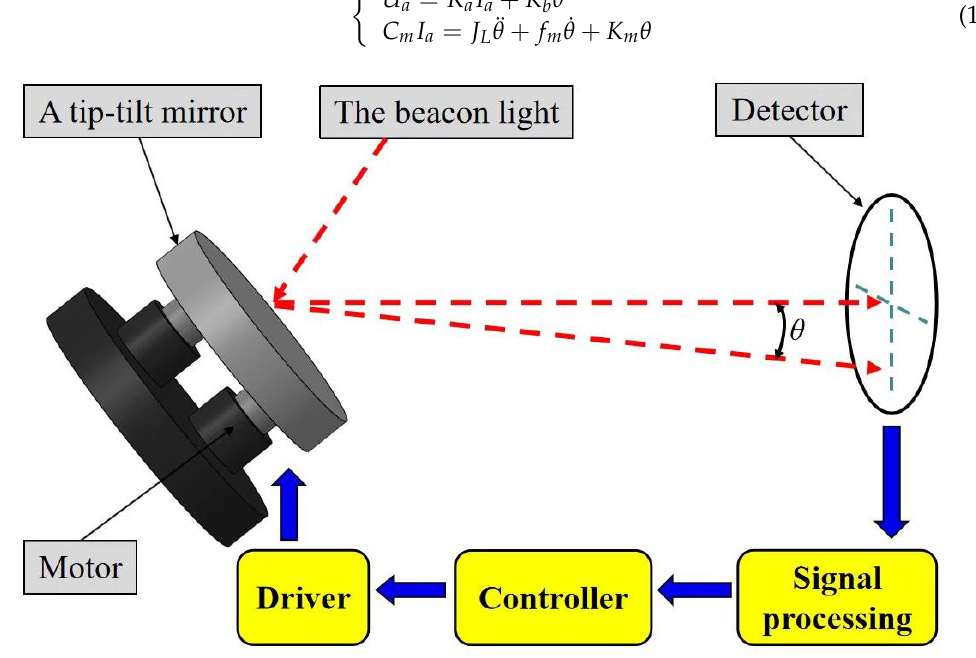
Figure 1. Schematic diagram of